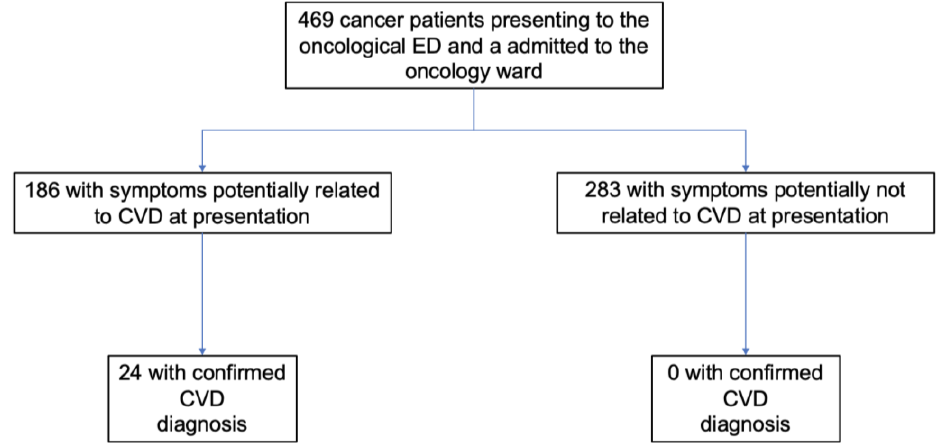
Figure 1. Flow diagram of study design. CVD, cardiovascular disease; ED, emergency department.